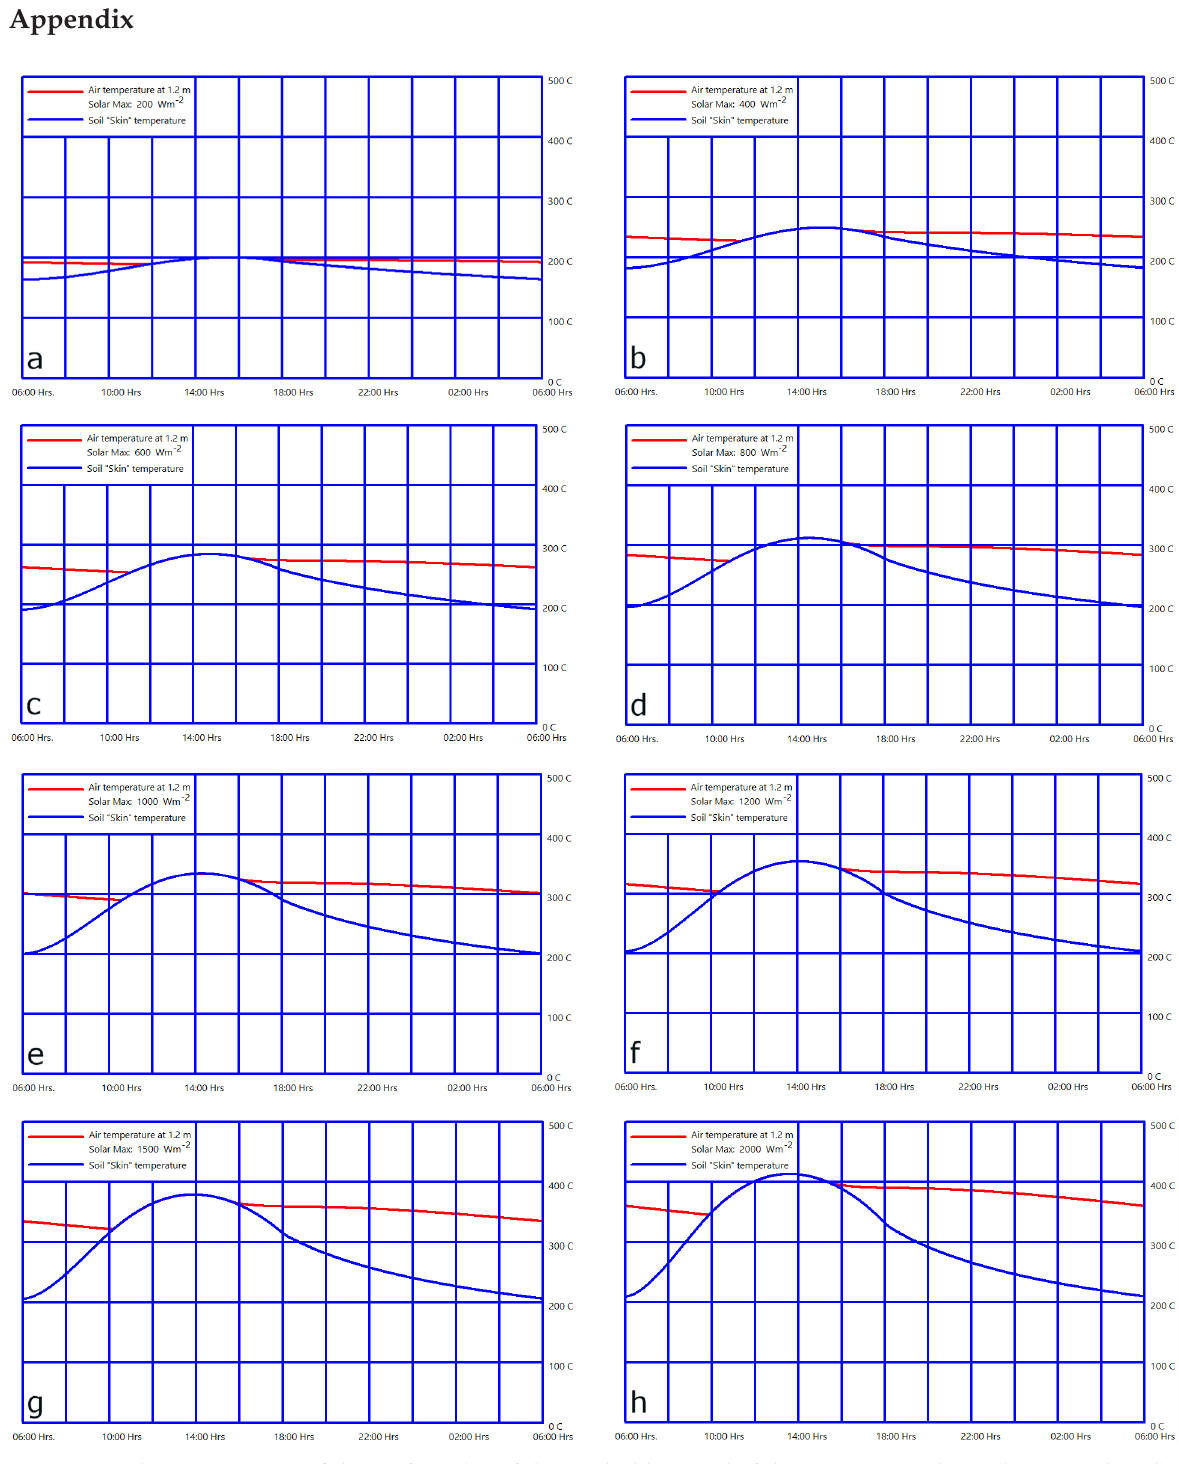
Figure A. The temperature of the surface skin of the earth (blue) and of the air at 1.2 m above the ground (red) over 24 h. The air is assumed to have a thermal conductivity of 0.03 W m −1 K −1 and a thermal capacitance of 1.006 kJ Kg −1 K −1 . For a maximum solar intensity of: a – 200 Wm −2 , b – 400 Wm −2 , c – 600 Wm −2 , d – 800 Wm −2 , e – 1000 Wm −2 , f – 1200 Wm −2 , g – 1500 Wm −2 and h – 2000 Wm −2